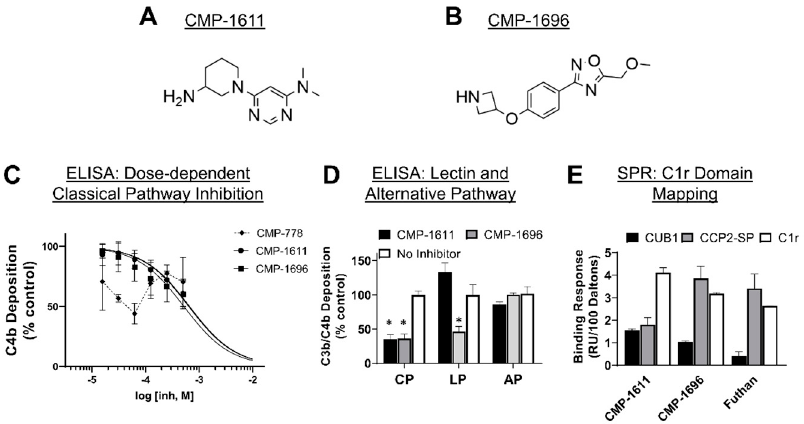
Figure 5. Selectivity and mechanistic analysis of CMP-1611 and CMP-1696. ( A ) Chemical structure of CMP-1611. ( B ) Chemical structure of CMP-1696. ( C ) Dose-dependent inhibition by CMP-1611 and CMP-1696 in a classical pathway-specific ELISA. Data were fit with GraphPad Prism using non-linear regression with a log(inhibitor) vs. response model. For CMP-1611, an IC 50 value of 660 µ M with an associated 95% confidence interval of (560–790 µ M, n = 9) was calculated. For CMP-1696, an IC 50 value of 520 µ M with an associated 95% confidence interval of (410–680 µ M, n = 7) was calculated. The CMP-778 inhibitory response could not be fit to a dose–response inhibition model. ( D ) Complement pathway selectivity of CMP-1611 and CMP-1696. Compounds were assessed for their ability to inhibit activation of complement via the lectin and alternative pathways using single doses of 500 µ M compound in triplicate. To ensure only lectin pathway activation, 2% ( v / v ) C1q-depleted serum (CompTech) was used and mannan was used as the activator. To match serum sources and amounts for this assay, the classical pathway assays were repeated here using serum from CompTech at 2% ( v / v ) final concentration. Alternative pathway activation assays were performed using 20% ( v / v ) serum (CompTech), alternative pathway bu ff ers, and C3b detection (see Methods and Materials for details). CMP-1611 had no e ff ect on the lectin or alternative pathway, whereas CMP-1696 blocked lectin but not alternative pathway activation. ( E ) C1r, C1r-CUB1, and C1r-CCP2-SP, were immobilized on an SPR sensor chip and binding responses for 500 µ M CMP-1611 and CMP-1696 or 10 µ M Futhan were each injected in duplicate over all surfaces. Binding responses were corrected for the molecular weight of each analyte and the immobilization level and molecular weight of each surface ligand. Measures of statistical significance in ( D ) were obtained by comparison of vehicle control using an unpaired t -test (* p <